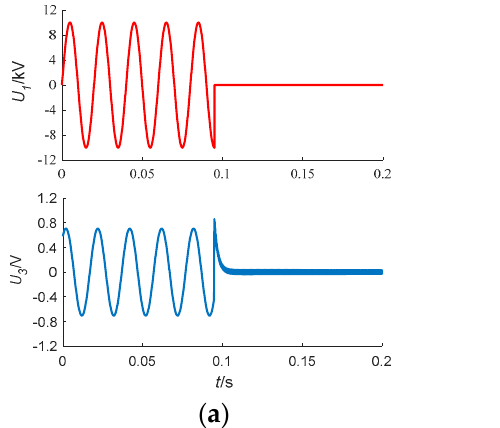
Figure 8. Input and output waveforms for different resistances. Impulse voltage, produced by short circuit, is 5.31 times as large as steady-state secondary voltage peak ( R = 10 Ω ). The secondary side voltage is abrupt at the moment of short circuit ( R = 0.2 k Ω ). The maximum value of the transient impulse voltage is already less than 10% of the steady-state voltage peak ( R = 2 k Ω ). In summary, the simulation results are consistent with the theoretical analysis. The resistor divider R , in the researched ECVT, should be adjusted to more than 2 k Ω to fulfill the standard requirement of the transformer. 4.1.2. Reclosing According to the operation experience, regardless of the situation of line disconnection lasting a long time, the upper limit of reclosing action time is about 0.5 s [37,38]. Furthermore, K 1 is disconnected at 0.005 s with 0.15 s as the time interval for reclosing, which is broken at the crest and closed at the trough. When R is 2 k Ω , the waveform of the secondary voltage is exhibited in Figure 9.